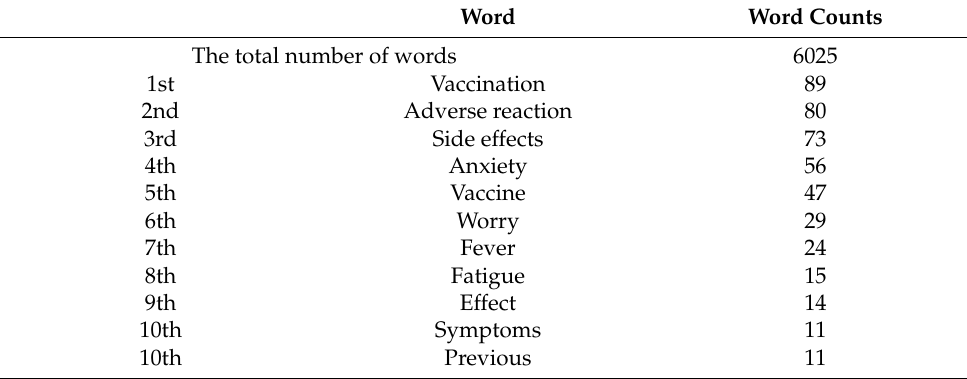
Table 3. List of frequently used words among nouns and adjectival